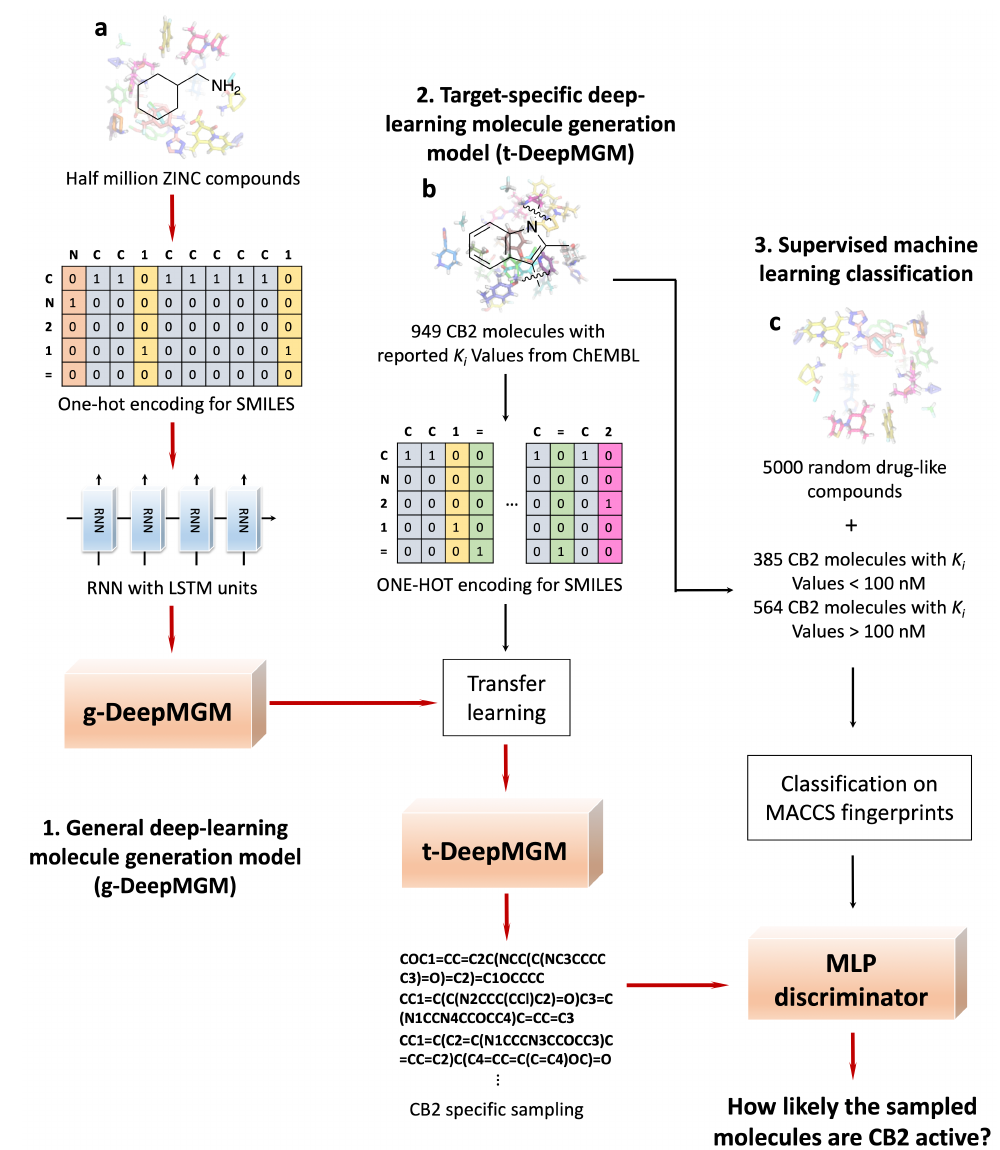
Figure 1. Schematic overview of the development pipeline for the general deep-learning molecule generation model, g-DeepMGM ( a ), and the target-specific deep-learning molecule generation model, t-DeepMGM ( b ) in combination with supervised machine-learning discriminator of multilayer perceptron ( c